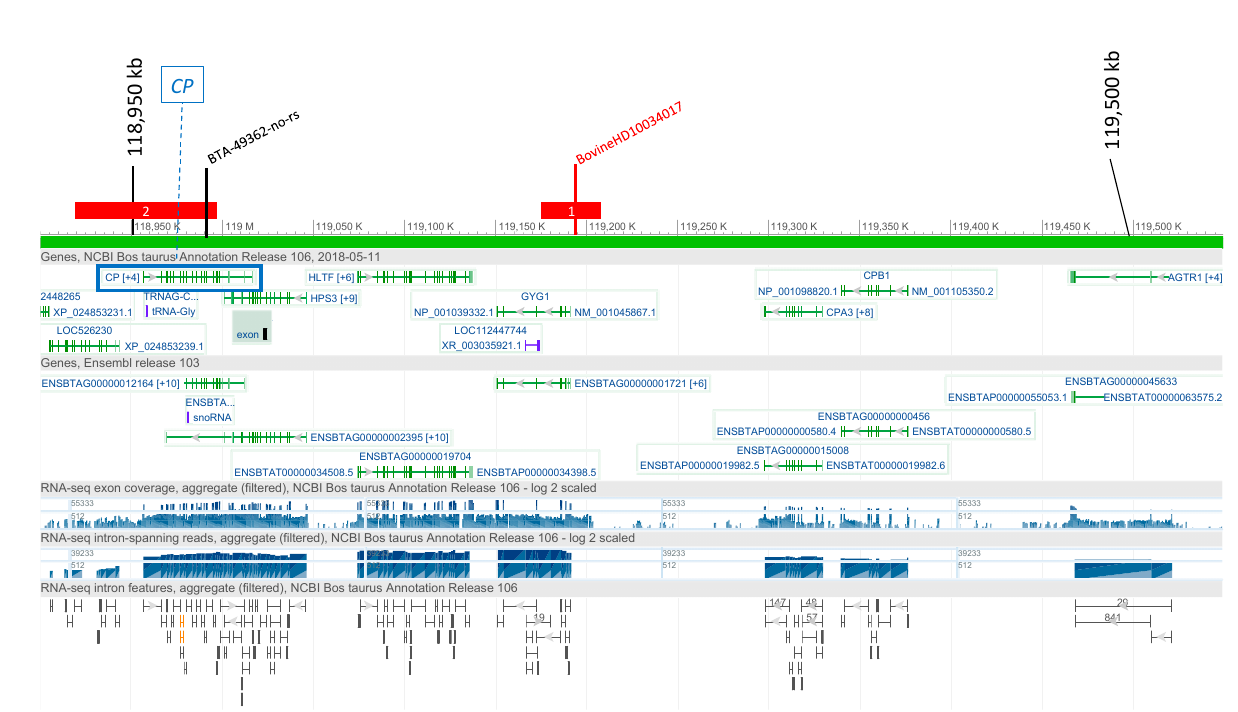
Figure 1. Association signals on BTA1 for ceruloplasmin. Single SNPs with SNP names are indicated, HaploBlocks are indicated as rectangles containing the number of overlapping HaploAlleles in the significant region. SNP markers and haploblocks are indicated: Black = Italian Holstein; red = Italian Simmental. The location of the ceruloplasmin gene ( CP ) is indicated by the blue box.